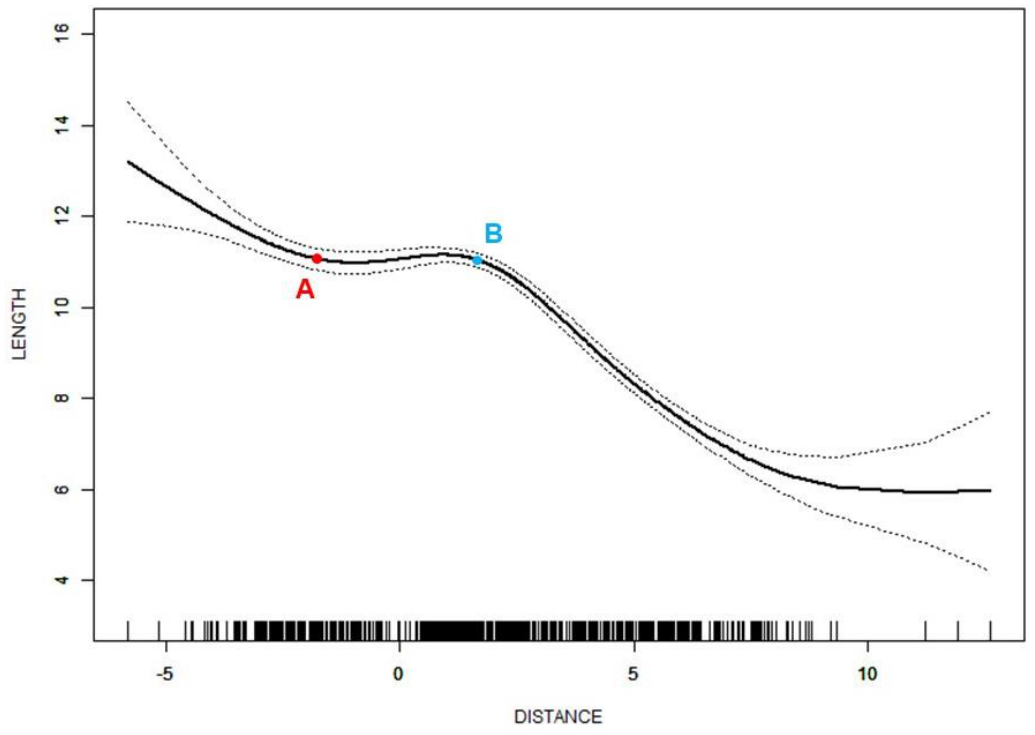
Figure 3. Nonlinear relationship between distance of disc displacement (mm) and disc length (mm). Adjusted for age and sex; A—the turning point of − 1.8 mm; B—the turning point of 1.7